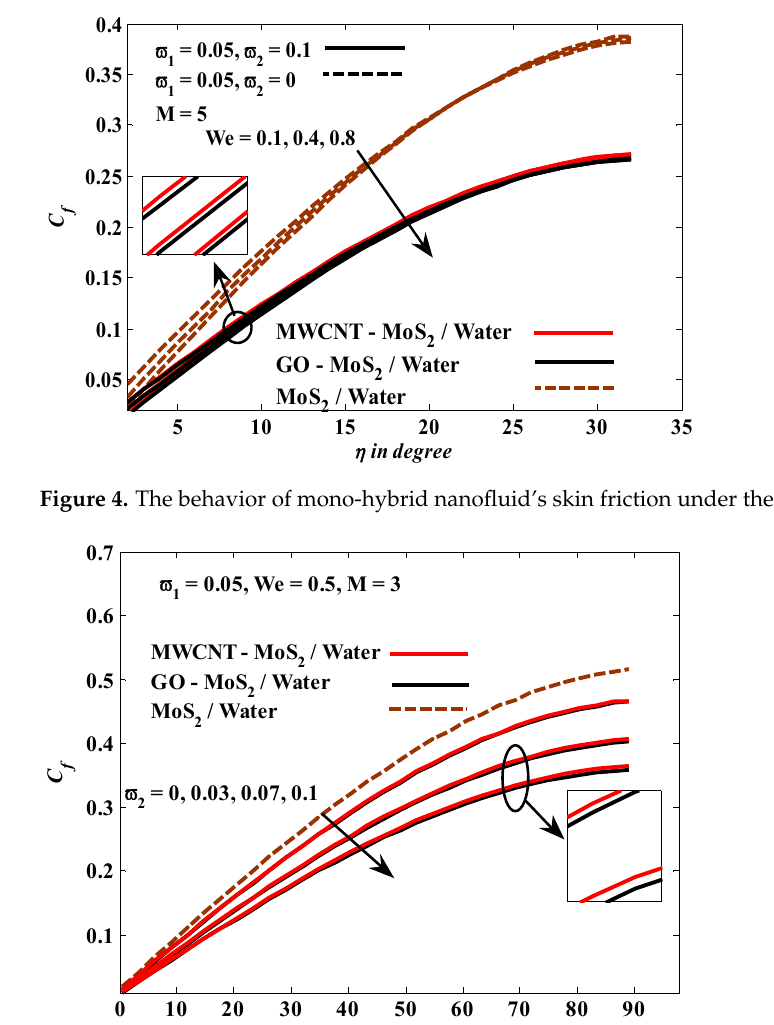
Figure 3. The behavior of hybrid nanofluid’s skin friction under the effect of M.